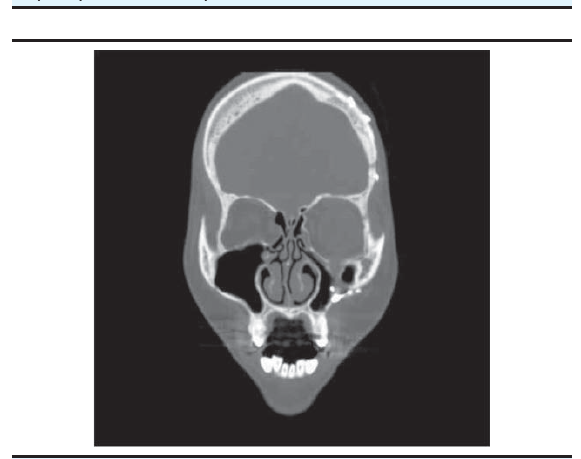
Figure 2. Coronal section of preoperative CT fi gures The fl oor of the left orbit is more lowered than that of the right side. The soft tissue has drooped through the fl oor.